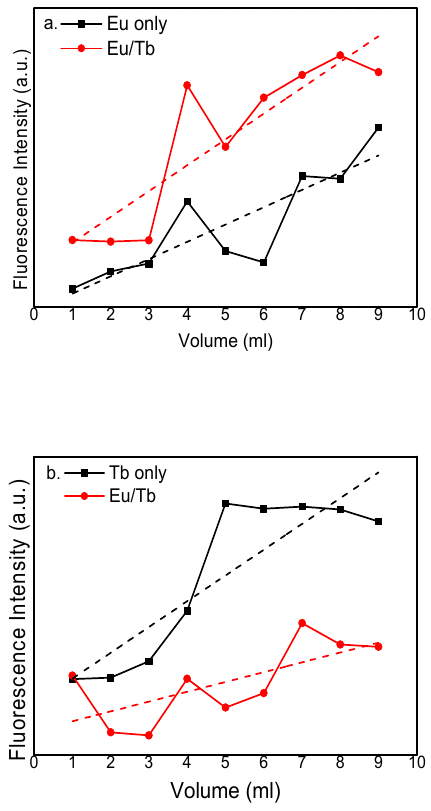
Figure 6. Fluorescence emission intensity of PVA fluorescent gel of ( a ) Eu and ( b ) Tb at different concentrations.